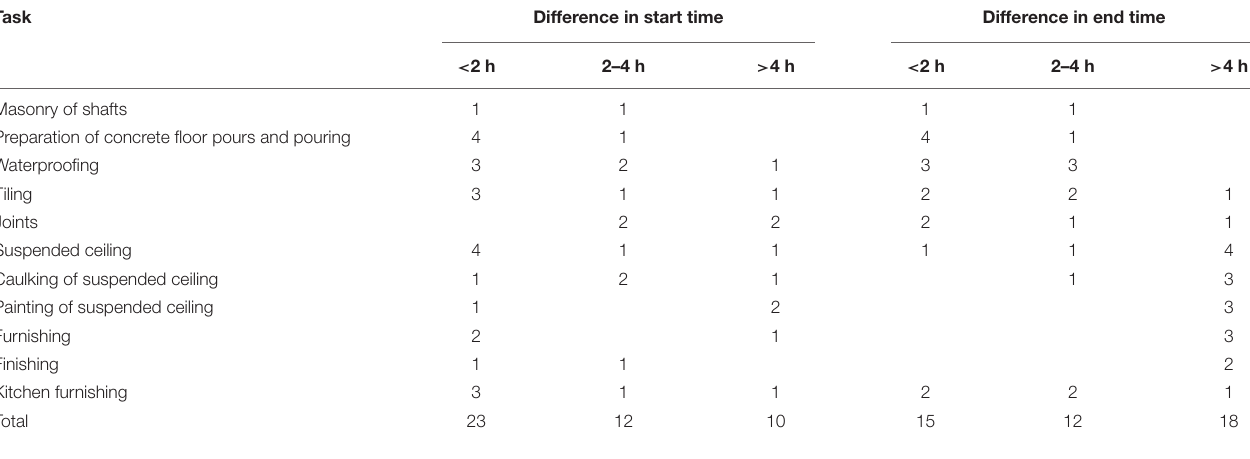
TABLE 4 | Differences between self-report data and the tracking results of the workers (number of observations).